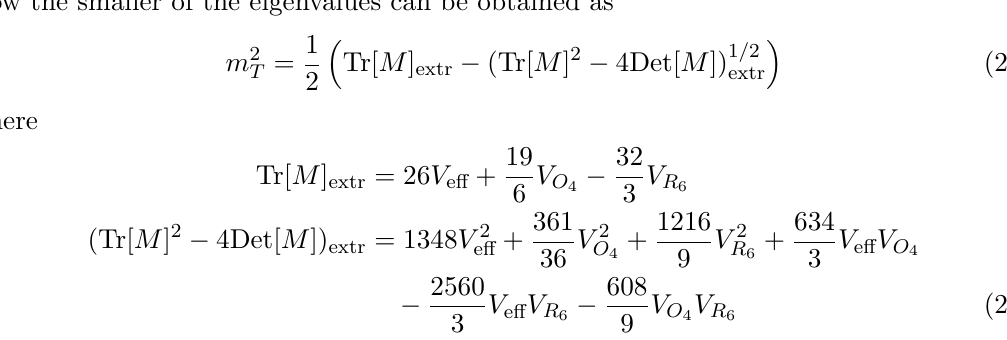
Figure 1 . Plot of allowed values of x (cid:17) V O to the